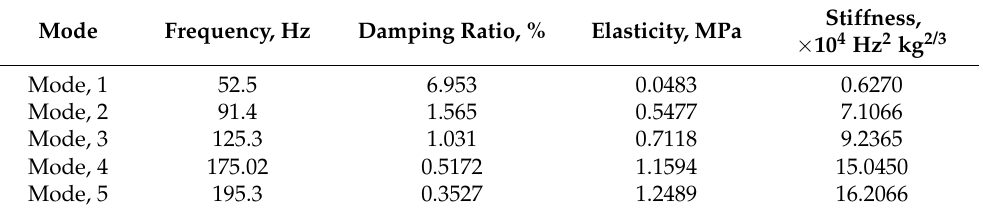
Table 6. Determining the natural frequency, damping ratio, elasticity, and stiffness factor for the cantaloupe fruit volume packing